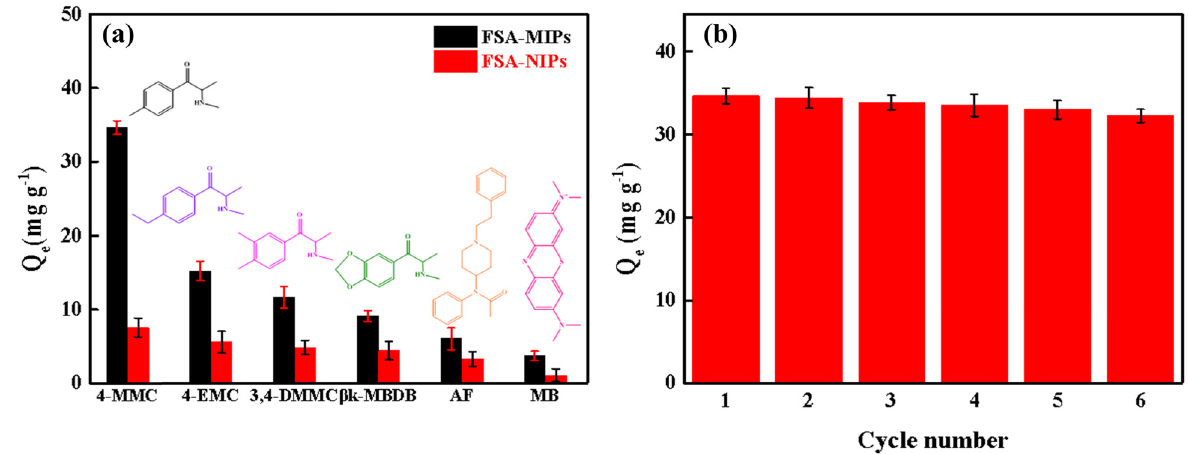
Figure 5: ( a ) Adsorption selectivity of FSA - MIPs and FSA - NIPs for 4 - MMC and its competitive compounds. ( b ) Regeneration performance of FSA - MIPs for 4 -